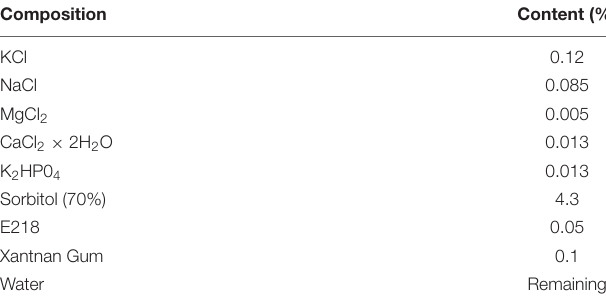
TABLE 1 | Chemical composition of artificial